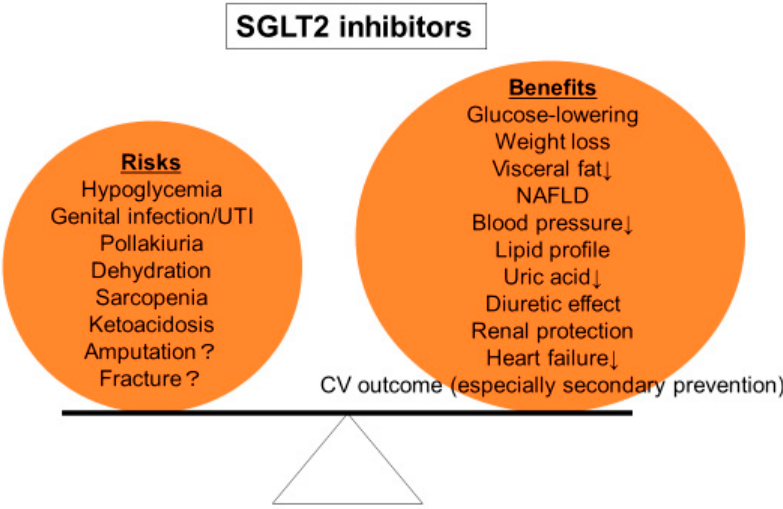
Figure 2. Risks and benefits of SGLT2 inhibitors. Treatment with SGLT2 inhibitors should be decided according to the balance between risks and benefits in each individual patient.